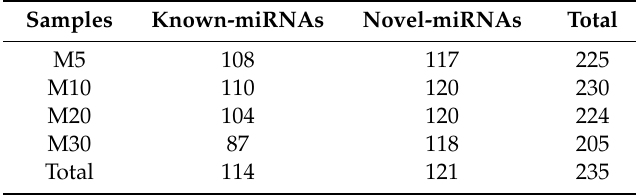
Table 2. Distribution of miRNAs in four libraries.